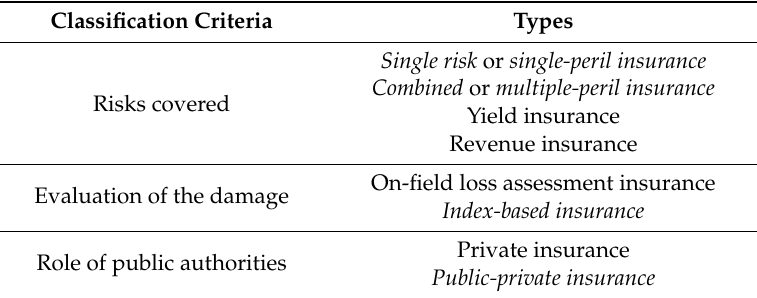
Table 1. Types of agricultural insurance schemes 1